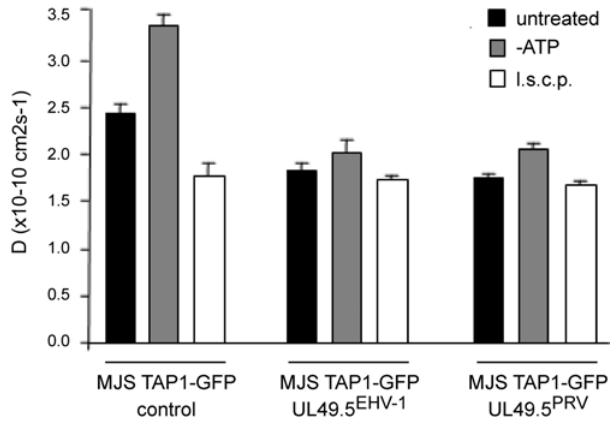
Figure 9. UL49.5 homologs arrest TAP in a translocation- incompetent state. The lateral mobility of the TAP complex was analyzed in MJS TAP1-GFP cells using confocal microscopy and FRAP. A circular spot in the ER was bleached and recovery of fluorescence was monitored. The half-time for recovery was determined and used to calculate the diffusion coefficient D. Where indicated, ATP was depleted (-ATP) or saturating amounts of substrate peptides (long side chain peptides, l.s.c.p.) were micro-injected into the